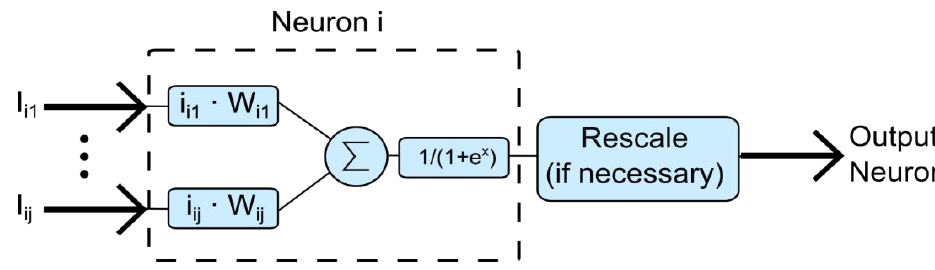
Figure 3. Artificial neuron of a multilayer perceptron network.